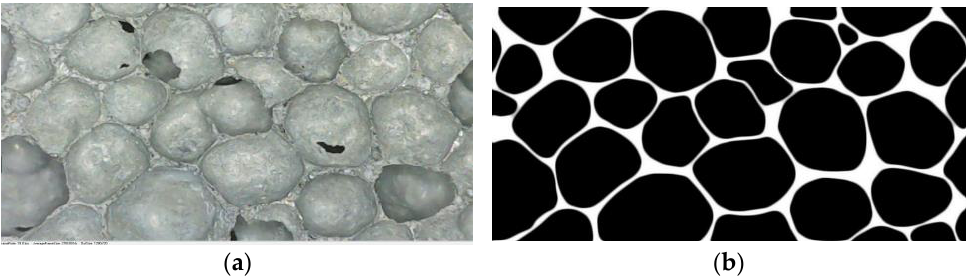
Figure 20. Image of pore cross-section with 0.1% fiber dosage: ( a ) original image, ( b ) cross-sectional image.